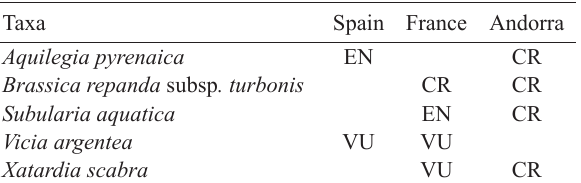
Table 2. Matching AFC species in the three RL and their